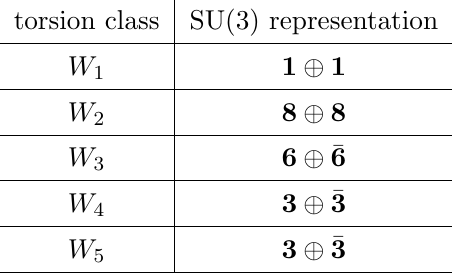
Table 1 . Torsion classes for SU(3) structures and their associated SU(3) representations.